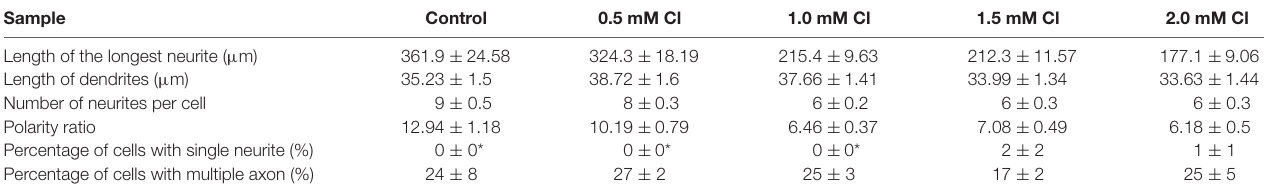
TABLE 6 | Developmental alterations of rat hippocampal neurons upon transient application of exogenous cholesterol for 10 min.